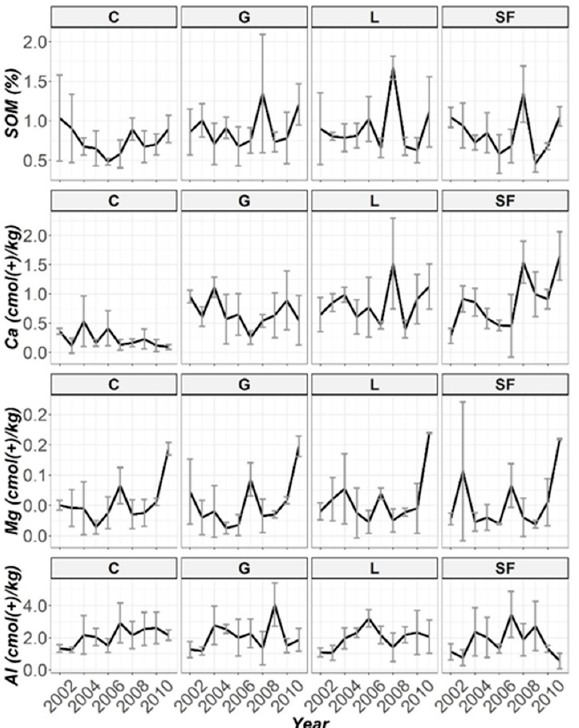
Figure 4. Temporal evolution of SOM, Ca, Mg and Al in the Ap2 horizon throughout the ten years of soil monitoring (2002–2011).